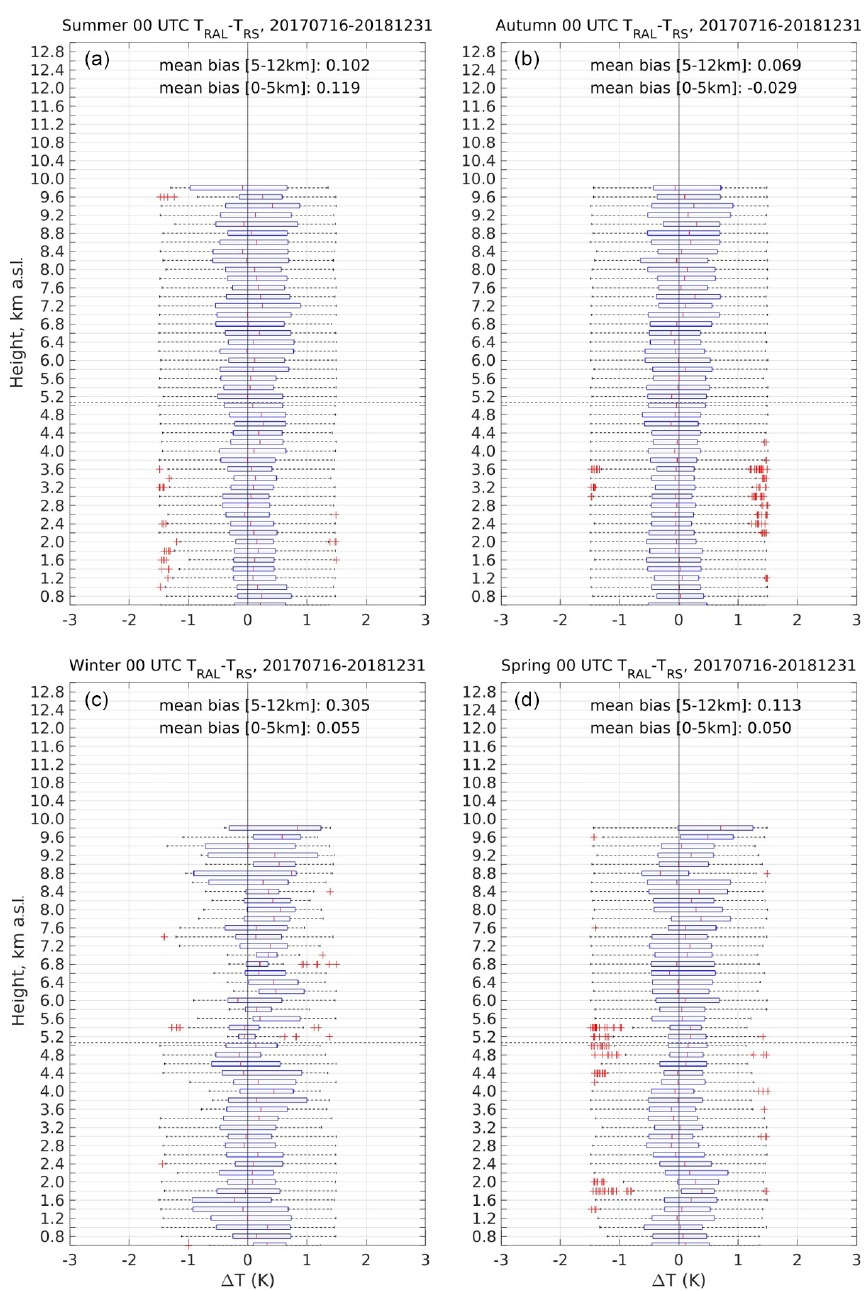
Figure 15. Seasonal nighttime bias of (cid:49)T over the period July 2017–December 2018. The boxplot characteristics are the same as for Figs. 10 and 11 but restricted over the seasonal periods. Based on the definition of seasons provided in the text, in clockwise order starting form the upper-left corner, panel (a) shows the summer data, panel (b) shows the autumn data, panel (c) shows the winter data and panel (d) shows the spring